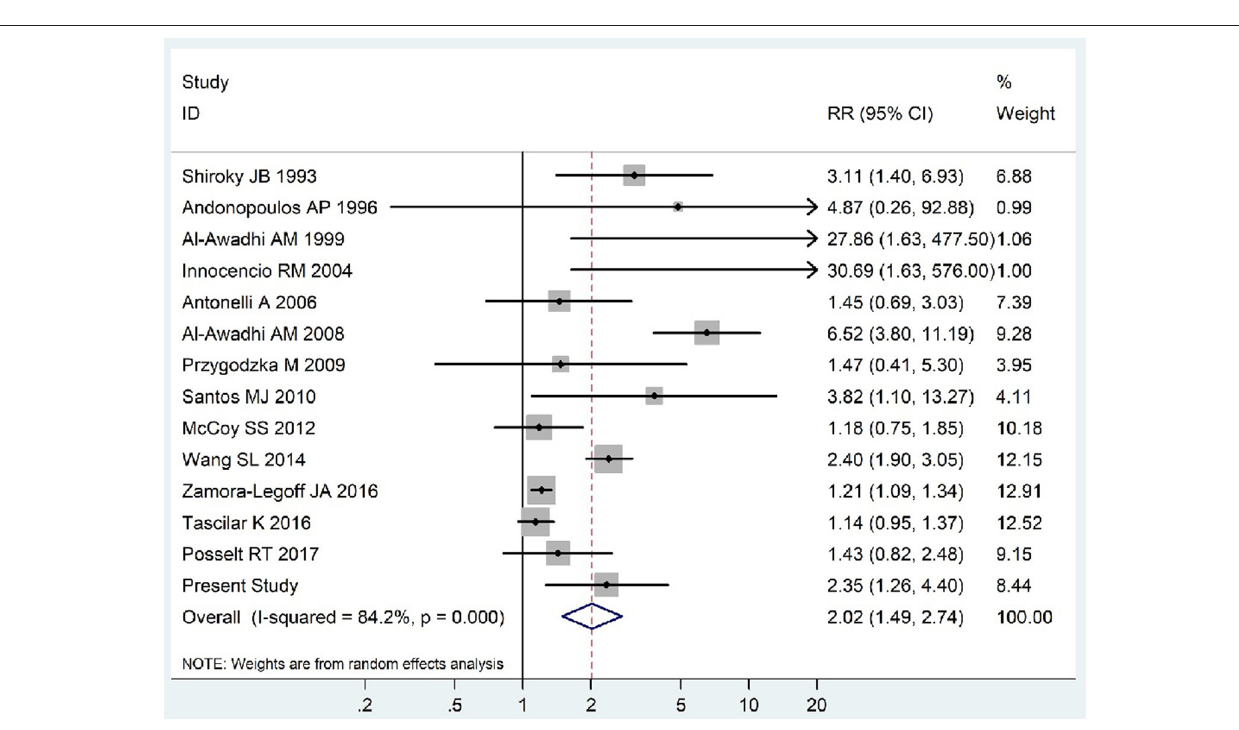
thyroid-related antibodies were significantly increased in RA patients as well the occurrence of thyroid dysfunction